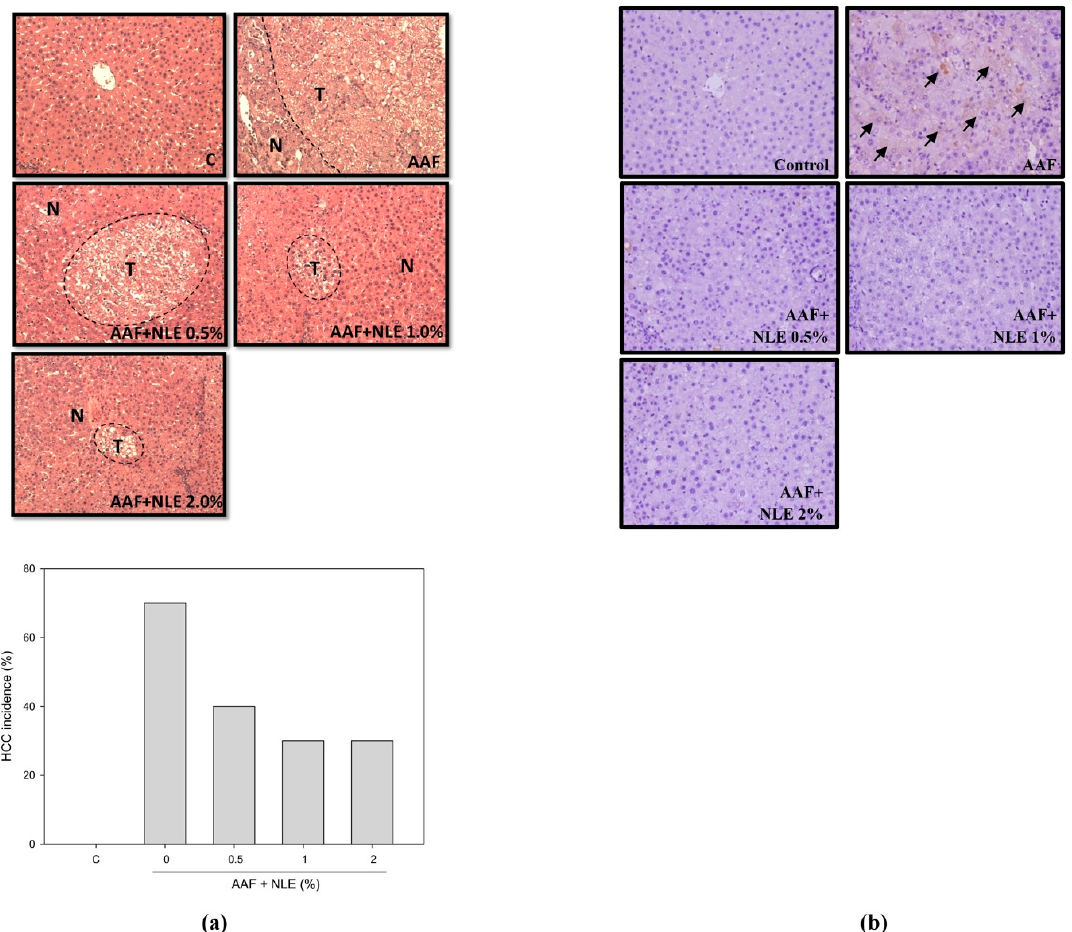
Figure 5. E ff ect of NLE supplementation on AAF-induced HCC. ( a ) The sections were stained with H&E and examined under a microscope at 100 × . N, normal hepatocyte; T, tumor. Livers from rats fed a normal diet (as the C group), a normal diet containing AAF (as the AAF group), a normal diet containing AAF with 0.5% NLE (as the AAF + NLE 0.5% group), a normal diet containing AAF with 1% NLE (as the AAF + NLE 1% group), and a normal diet containing AAF with 2% NLE (as the AAF + NLE 2% group) were fixed, embedded, and sectioned. The incidence of hepatocellular carcinoma with or without NLE supplementation in AAF-induced rats was calculated. ( b) Effect of NLE supplementation on the expression of glutathione S-transferase-Pi (GST-Pi) induced by AAF in the liver of rat (arrow head). Livers from Wistar rats were fixed, embedded, and sectioned. The sections were stained with anti-GST-Pi and examined under a microscope at 200×.